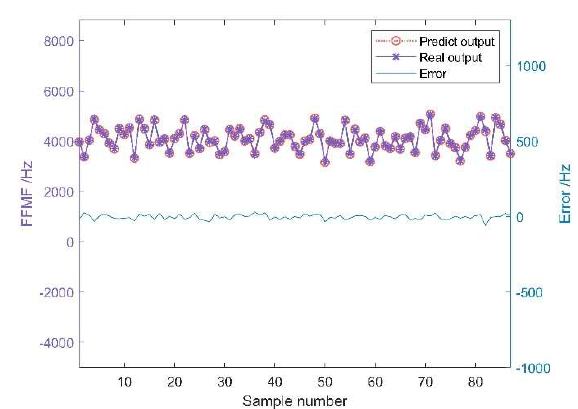
Figure 13. The comparison of the results of the FMF test set. Table 3. Evaluation of the predictive effect of FMF.